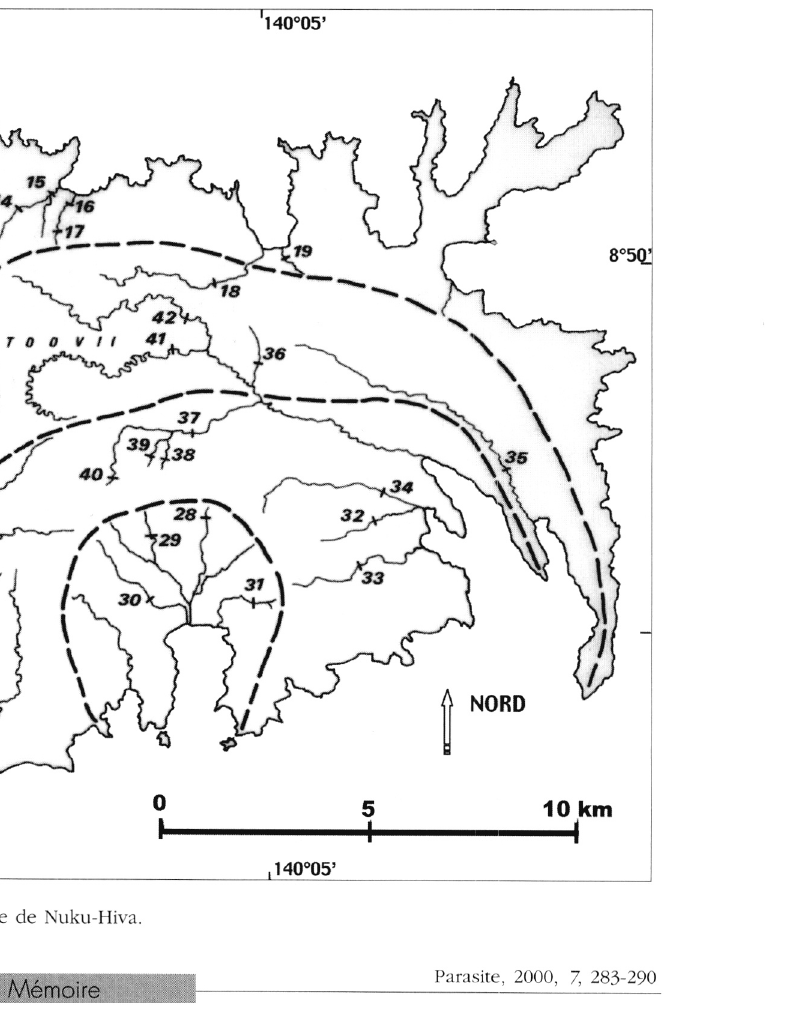
Fig. 1. - Positionnement des stations d’échantillonnage sur l’île de